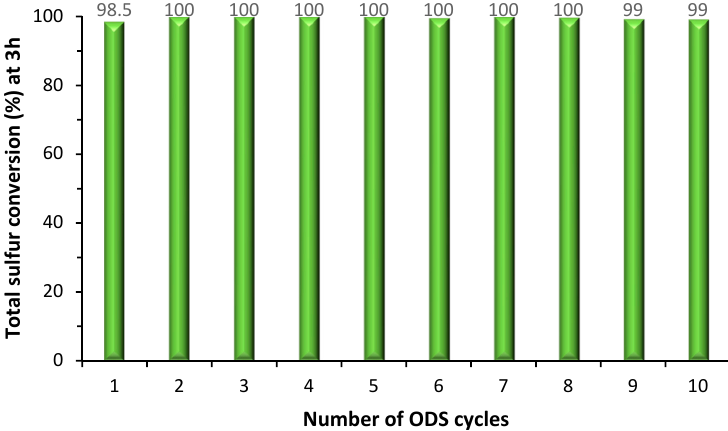
Figure 3. Desulfurization results of a multicomponent model diesel after 3 h for ten consecutive cycles, using a solvent-free system with H 2 O 2 /S = 3 and catalyzed by TBA[PW 11 ].